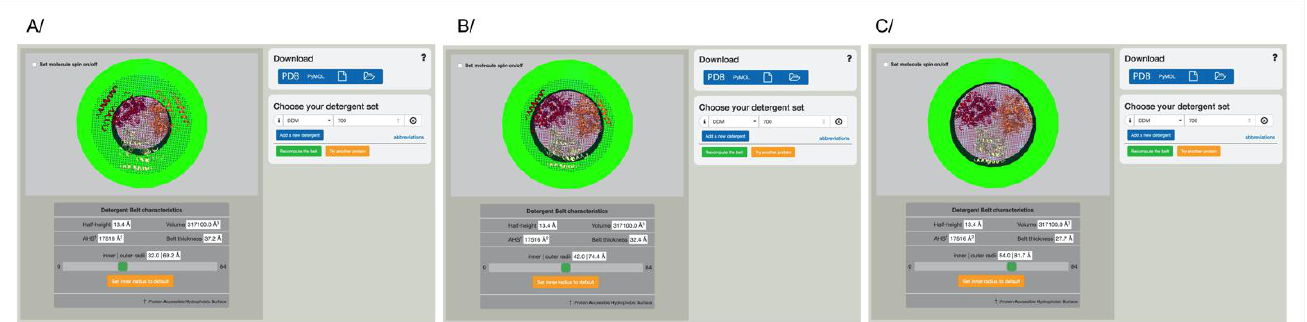
Figure 5. Variation of the detergent belt by changing the inner radius. The scroll bar can be adjusted to displace the position of the inner radius for the detergent belt cylinder, larger or smaller. Metrics are automatically adjusted, as well as the display. The belt can also be set back to the original default value.